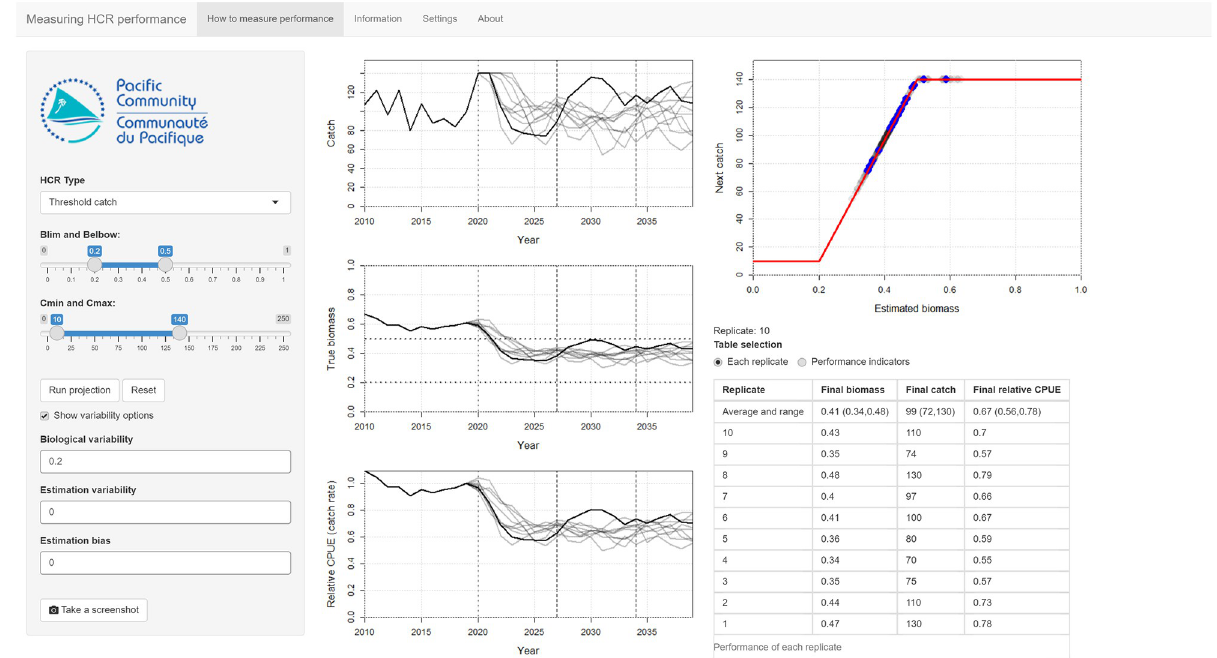
Fig 3. A screenshot of the main page of the Measuring performance app. The controls that set the shape of the HCR and the variability options are in the left-hand panel. Biological variability has been switched on to include uncertainty in the results. In this example, the Run projection button has been pressed ten times so that ten replicates have been run. The most recent replicate is shown as a black line in the time series plots. The previous replicates are shown as grey lines. On the HCR plot at the top right, the blue dots are the parts of the HCR that were ’active’ in the most recent replicate. The grey dots are from the previous replicates. The table shows the biomass, catch and relative CPUE in the final year of the projection. The top row of the table gives a summary of these metrics as the median and the 90th percentile range.